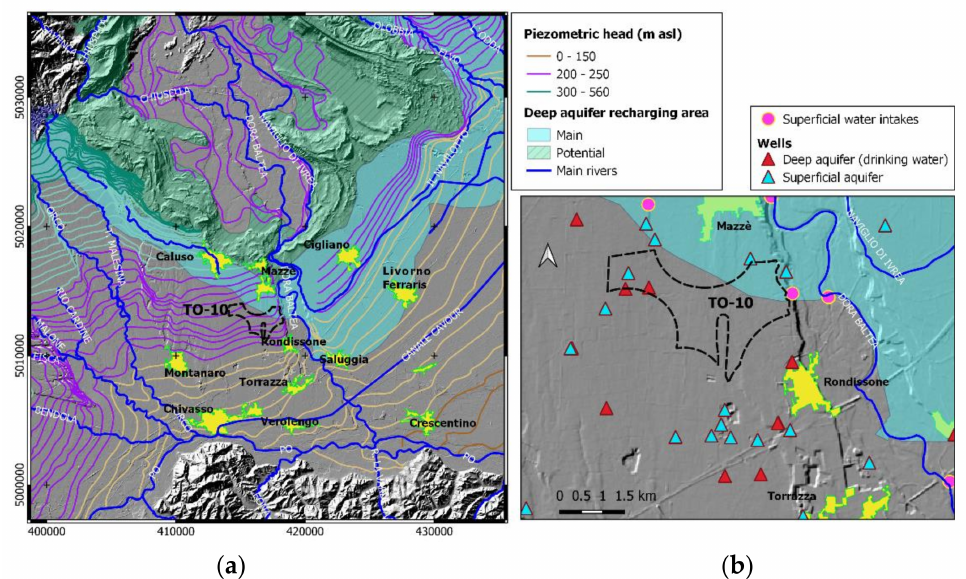
Figure 8. ( left ) Hydrogeological sketch of the TO-10 site and its surroundings. Contour lines for isopiezometric heads show the groundwater table geometry. Light blue areas report the recharge areas of the deep aquifer (that provides drinking water). In yellow the main towns around the area; blue lines represent the main hydrological network. ( right ) Detail of the TO-10 area and its surroundings: ( a ) the recharge area of the deep aquifer is partially included in the site; ( b ) several wells are located nearby or within the area; eight out of them catch the water from the deep aquifer. Reference system is WGS84 UTM